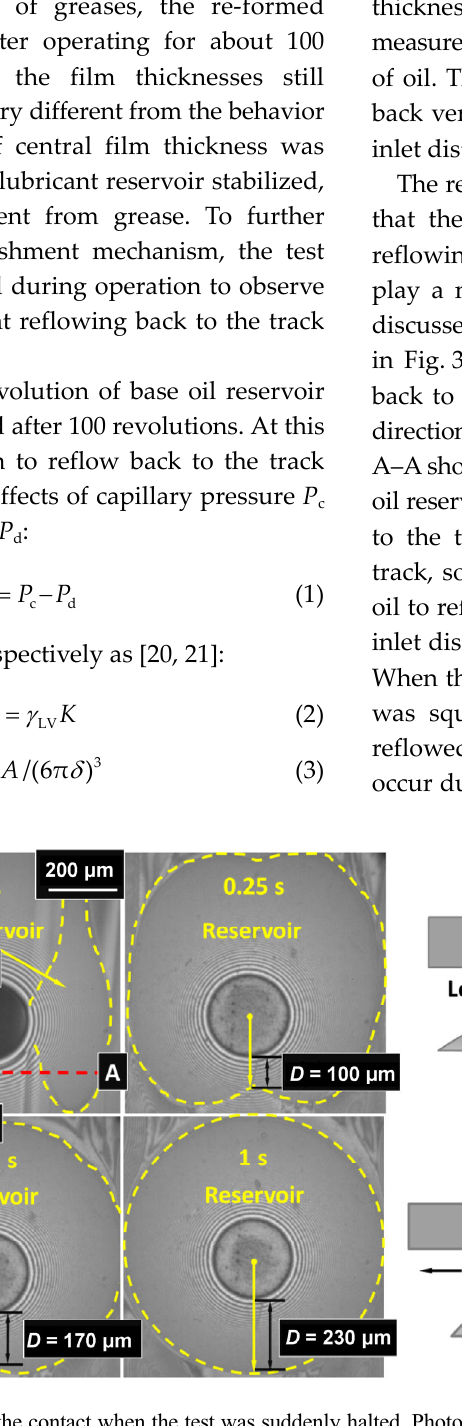
Fig. 3 Oil reflowed back to the contact when the test was suddenly halted. Photos on the left show the reflowing process after the test rig was halted; diagrams on the right show that oil was driven to reflow back to the track by P c , P d , and P from two dimensions. D represents the inlet distance, which is the distance between the meniscus of lubricant reservoir and Hertzian contact in the inlet